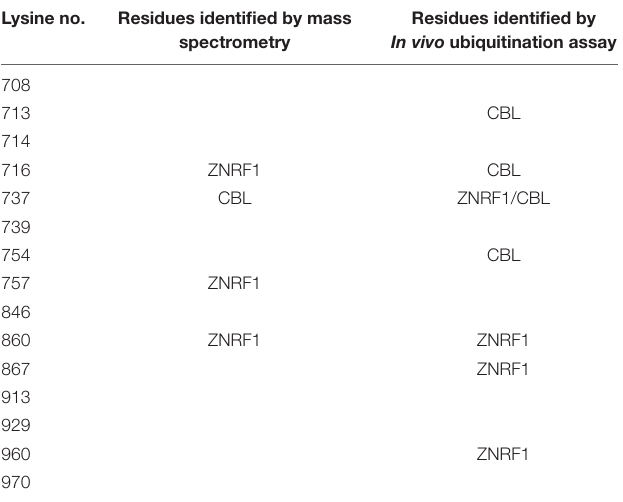
TABLE 1 | Summary of ubiquitin-modified lysine residues on EGFR mediated by ZNRF1 and CBL in response to EGF. Lysine no.